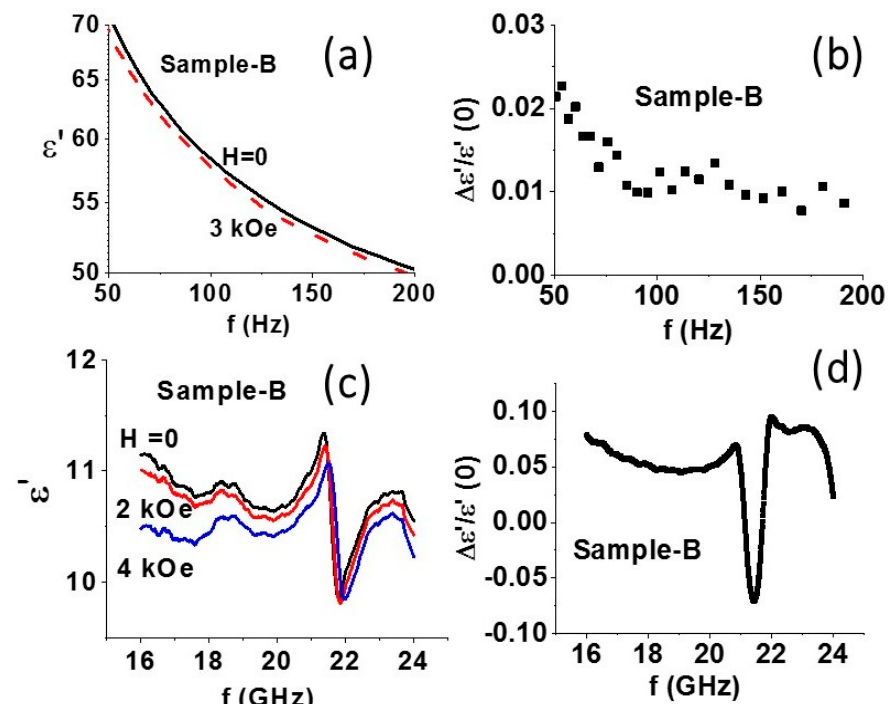
Figure 5. ( a ) Frequency dependence of the real part of the relative permittivity ε′ for discs of NFO–BTO fibers. Data are for static magnetic field H parallel to the disc plane. ( b ) Estimated fractional decrease in ε′ vs f from data in Figure 5a. ( c ) Data on ε′ vs f for a series of H for a rectangular disc sample of NFO–BTO core–shell fibers oriented in a magnetic field. The sample dimension was chosen so that dielectric resonance was present in the sample in the above frequency range. ( d ) Estimated fractional change in ε′ vs f from data in Figure 5c.